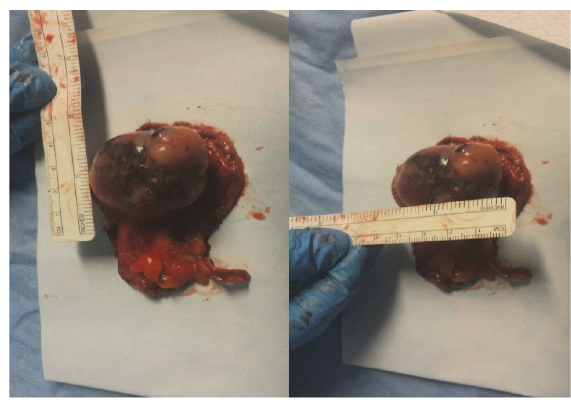
Figure 1: Surgical specimen: grossly polypoid neoformation with a large implant